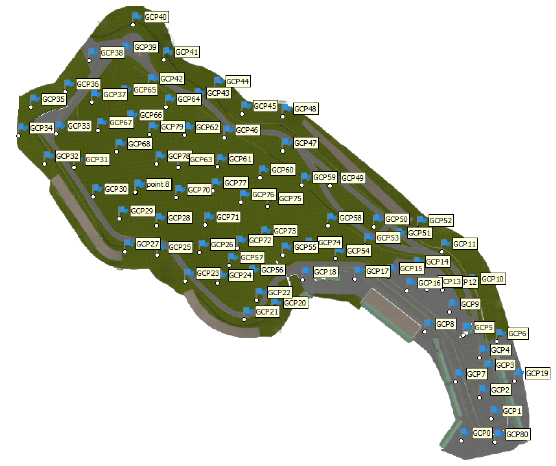
Figure 6. GCPs locations on the Sonoma Raceway virtual world.